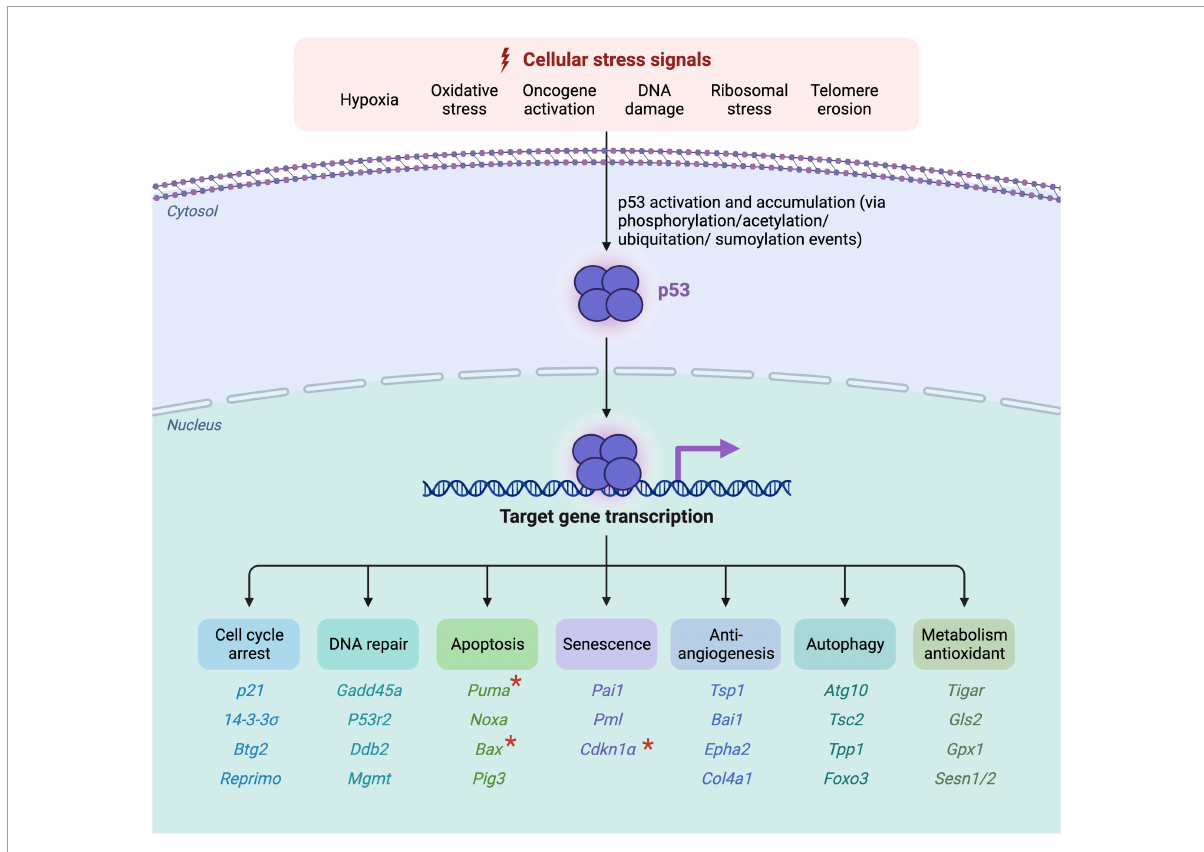
FIGURE1 Overview of p53-activation, target gene induction and its corresponding functioning. Active oncogenes or the accumulation of cellular damages and stressors lead to the phosphorylation, acetylation, ubiquitation or sumoylation of p53 via the activation of kinases and transcriptional factors. Following its activation, p53 binds to its corresponding DNA-promoter-regions, through which cell cycle arrest, DNA repair mechanisms, apoptosis, senescence, anti-angiogenic, autophagic or antioxidant metabolism mechanisms are induced. The corresponding target genes are listed below the according function. The “*” marked genes represent neurodegenerative p53-influenced downstream targets, discussed in this review (Created with